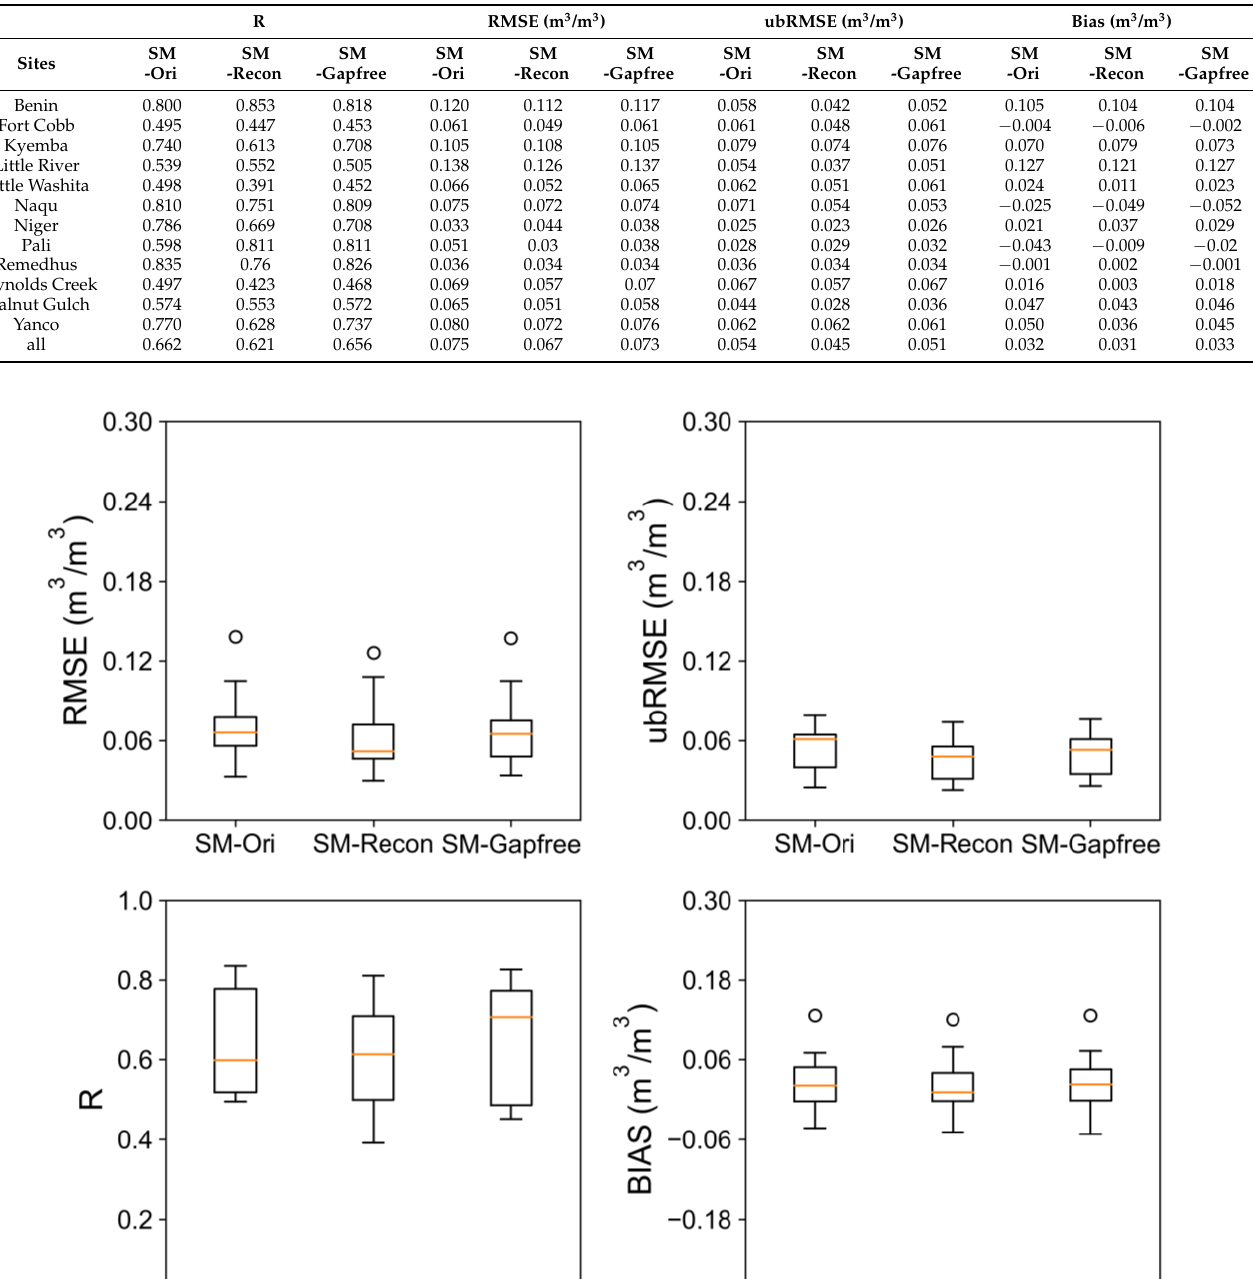
Table 3. Statistical comparisons of the SM-Ori, SM-Recon, and SM-Gapfree with the in situ SM.